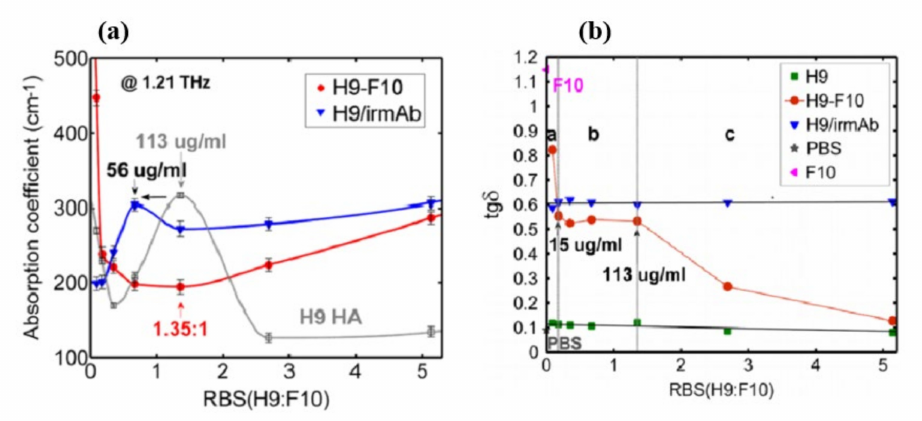
Figure 12. ( a ) Plot of tan δ versus ratio of binding sites of H9 HA and F10 and negative control, and H9 HA solutions. ( b ) Specificity and sensitivity measurements by ELISA. Reprinted with permission from [68]. Copyright 2015